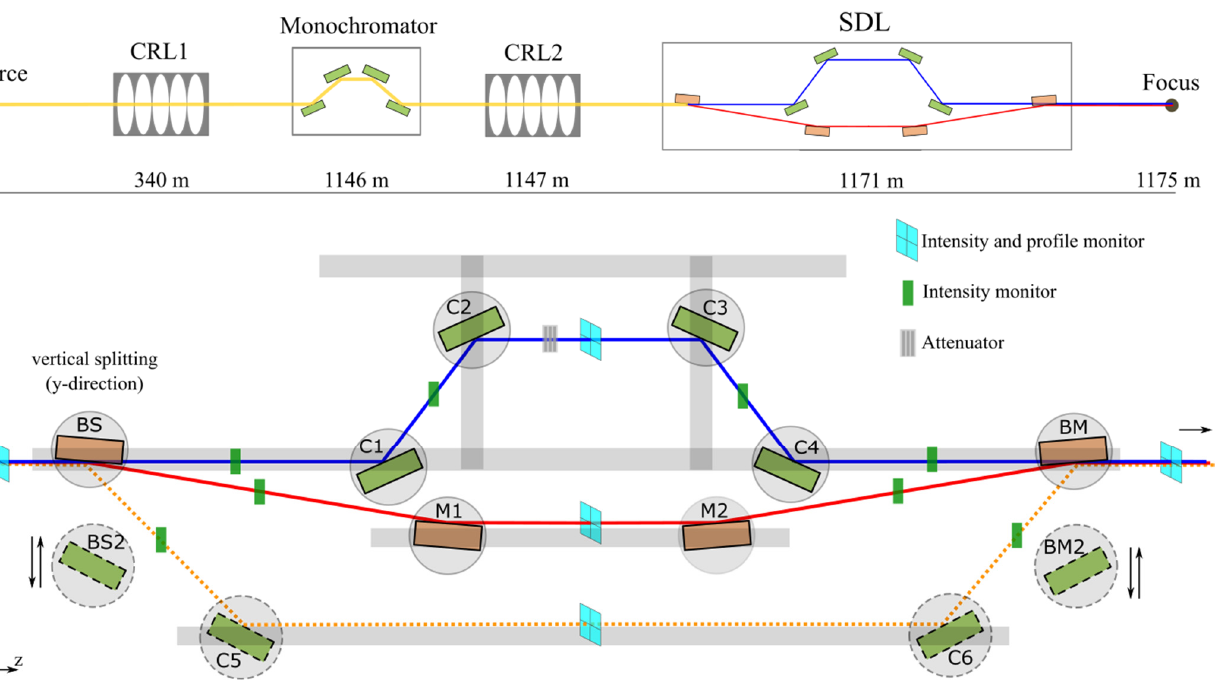
Figure 1. ( a ) Beamline layout of the CDE endstation. CRL1 is used to collimate the beam and CRL2 to focus the beam. The retractable monochromator is composed of 4 Si111 crystals. ( b ) Top-view illustration of the hybrid SDL. BS denotes the beam splitter, BM the beam merger, C1–C6 crystals, M1–M2 multilayers, BS2 the spare beam splitter, and BM2 the spare beam merger. The dashed lines denote the beam path of the optional third branch. All stages (circular region) can slide along the guide rails (shadowed region).